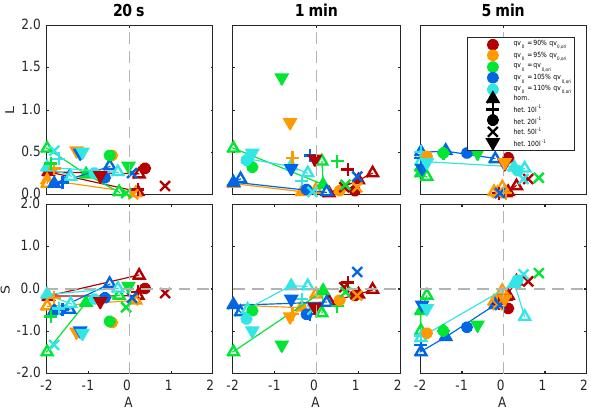
Figure 10. SAL for ZOMM simulations with modified initial mois- ture content (colours), different nucleation modes (filled symbols) and with additional superimposed small-scale temperature fluctua- tions (coloured lines and open symbols). Open symbols: best and worst prediction in terms of the SAL metric from the 20 runs with different superimposed small-scale temperature fluctuations. Left column: SAL for offline trajectories with a temporal resolution of 5min. Middle column: SAL for offline trajectories with a temporal resolution of 1min. Right column: SAL for online